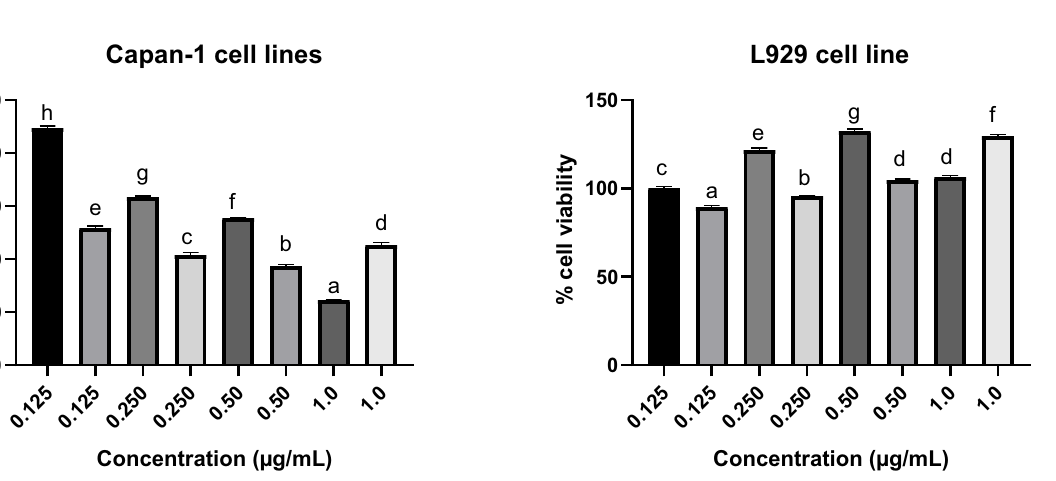
In L929 cell lines ( Figure 7 ) , extract and nanoparti - cles have no lethal e ff ect on L929 cell lines, which are the mouse normal fi broblast cell lines. That means nanopar - ticles have no harmful e ff ect on normal cells.